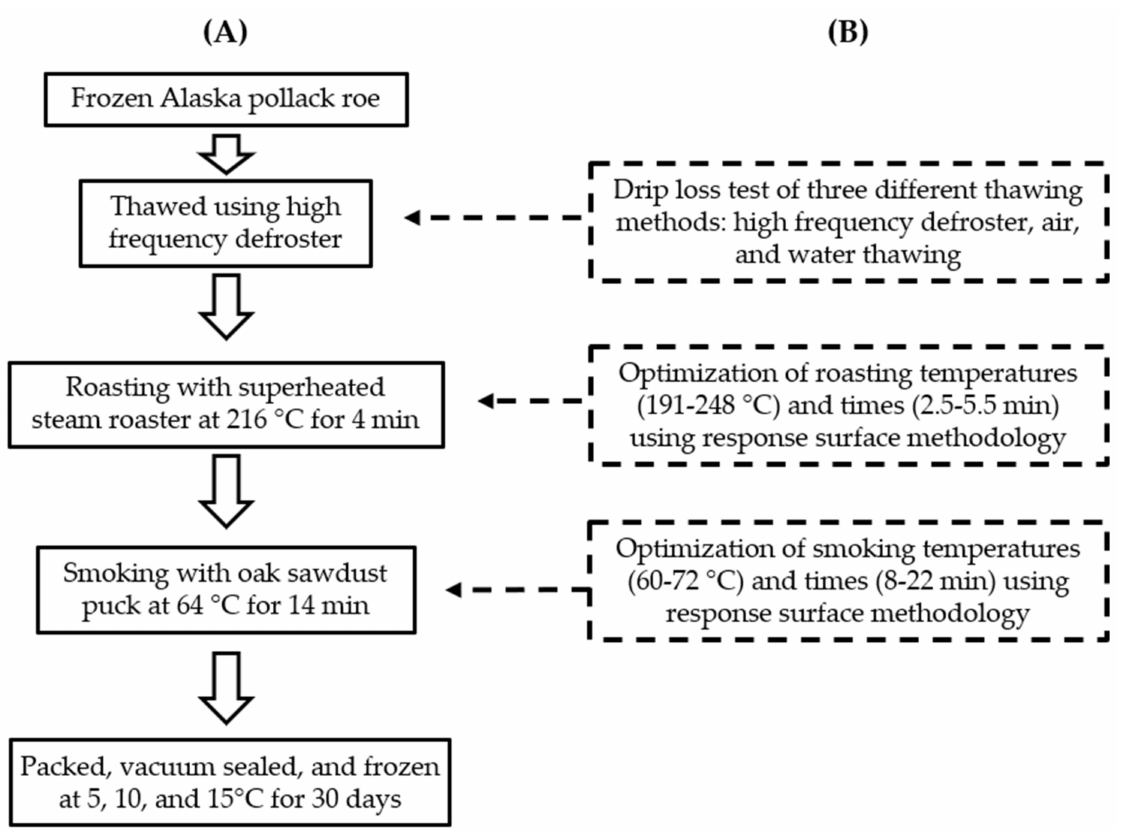
Figure 1. Processing steps of smoke-roasted Alaska pollack roe. The final product processing flow ( A ) was obtained from the designed experiment ( B